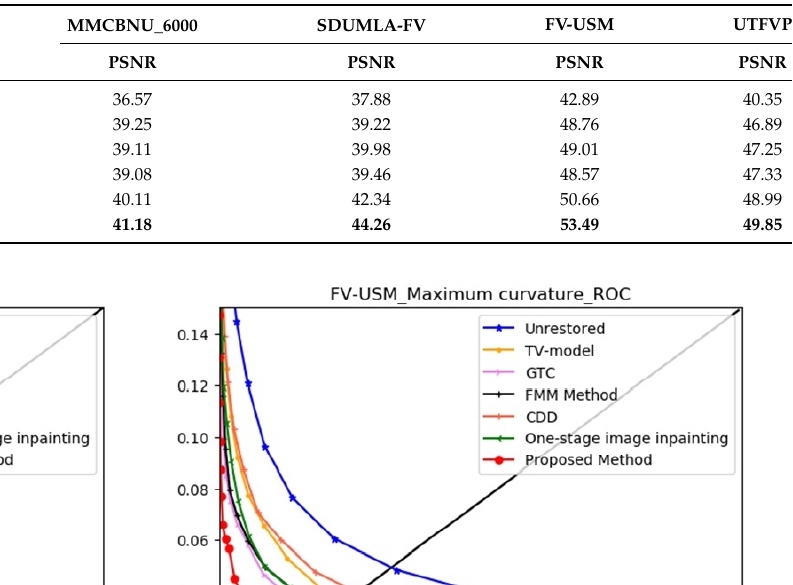
Table 10. PSNR (dB) of various image inpainting methods on different public datasets.